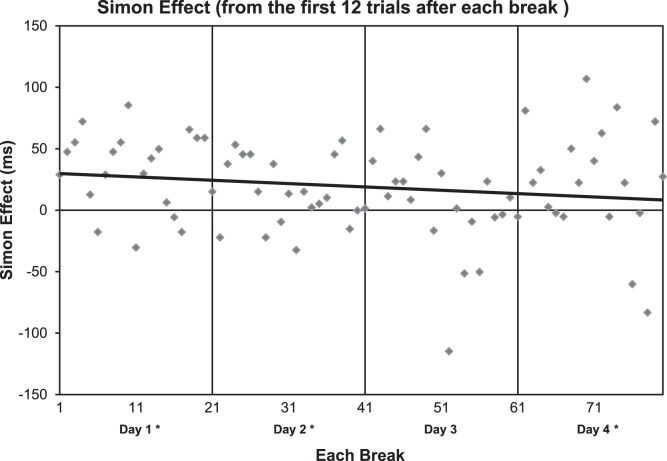
Simon effect calculated from first 12 trials after each break from the same data as shown in Figure 2.All four days of testing were plotted together for comparison. The Simon effect was present for all days except for day 3. As indicated by the line of best fit, the overall trend of the Simon effect for the 12 trials decreased over the four days of training.